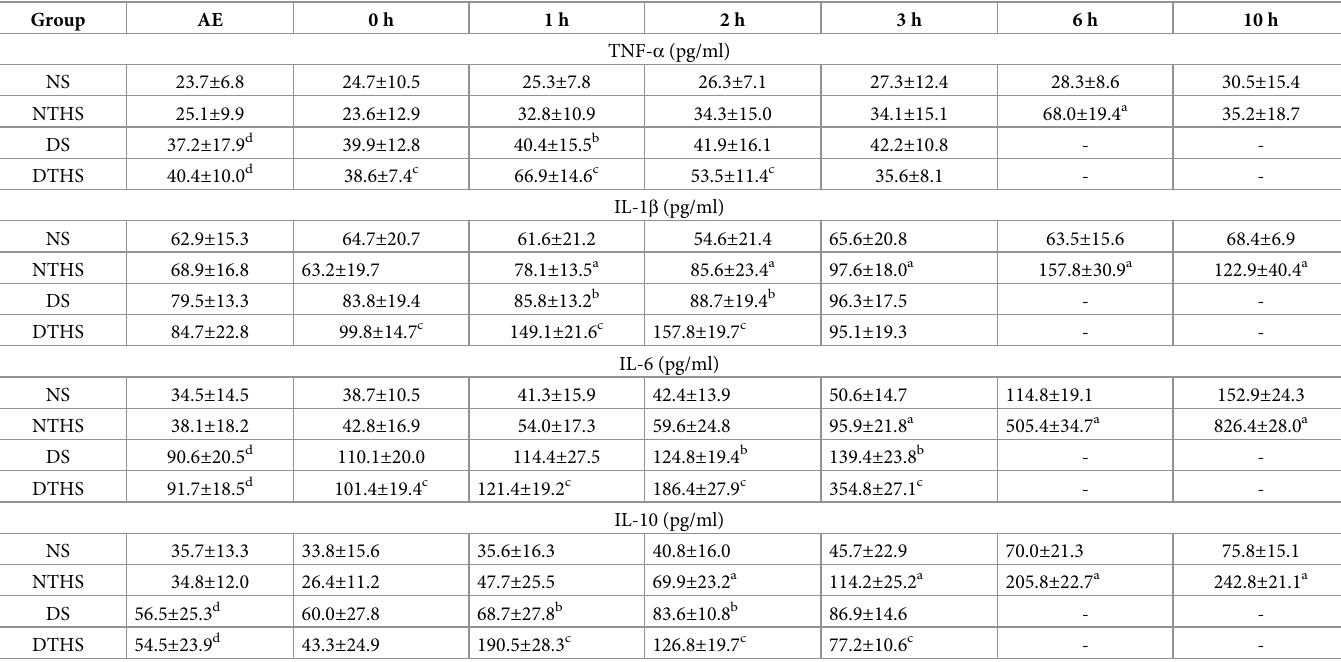
AE, after exposure. Values are shown as mean ± SEM. P < 0.05 was considered statistically significant. a P, b P, and c P denote a statistically significant difference for NS vs. NTHS, DTHS vs. DS, and DTHS vs. NTHS at the same time point, respectively; d P denotes dry-heat temperature environment vs. normal environment after